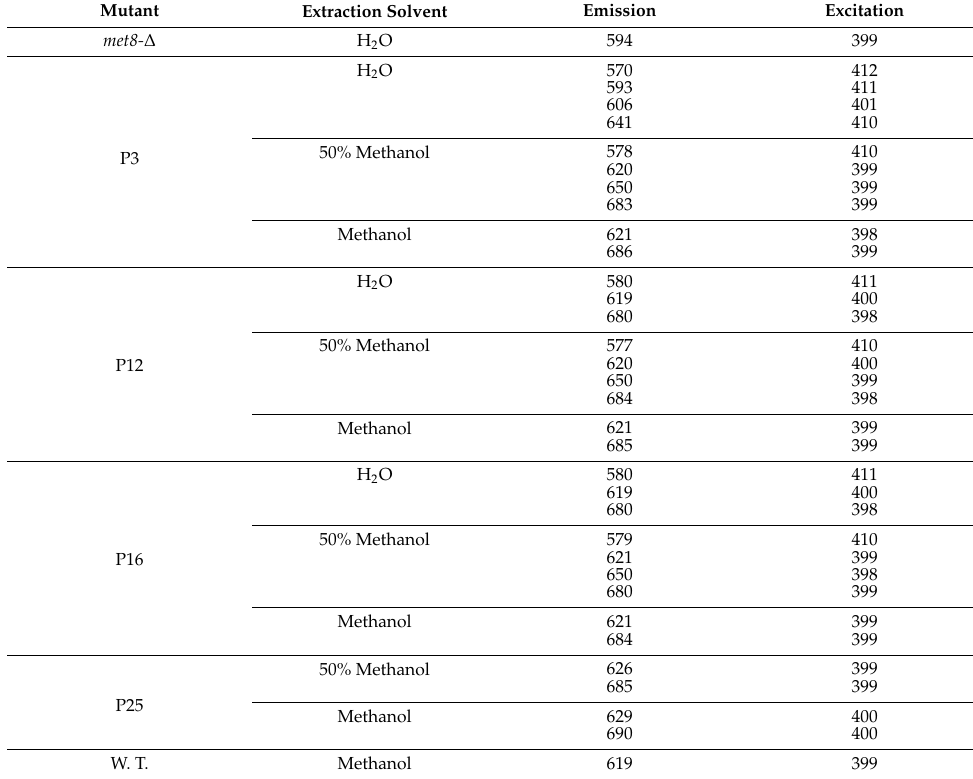
Table 1. Fluorescence emission and corresponding Soret excitation bands (nm) in cell extracts of mutants accumulating free base